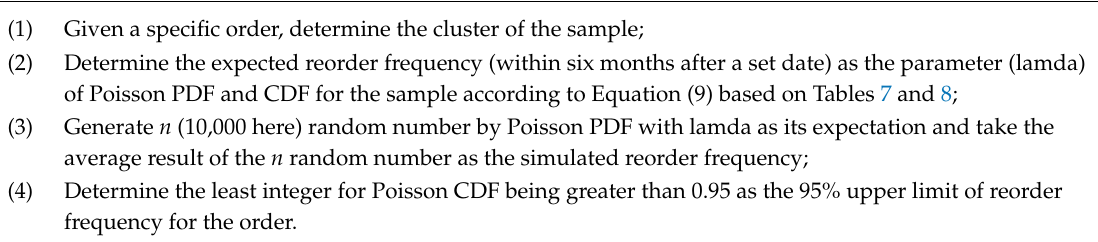
Algorithm 5. Monte Carlo simulation of reorder times.